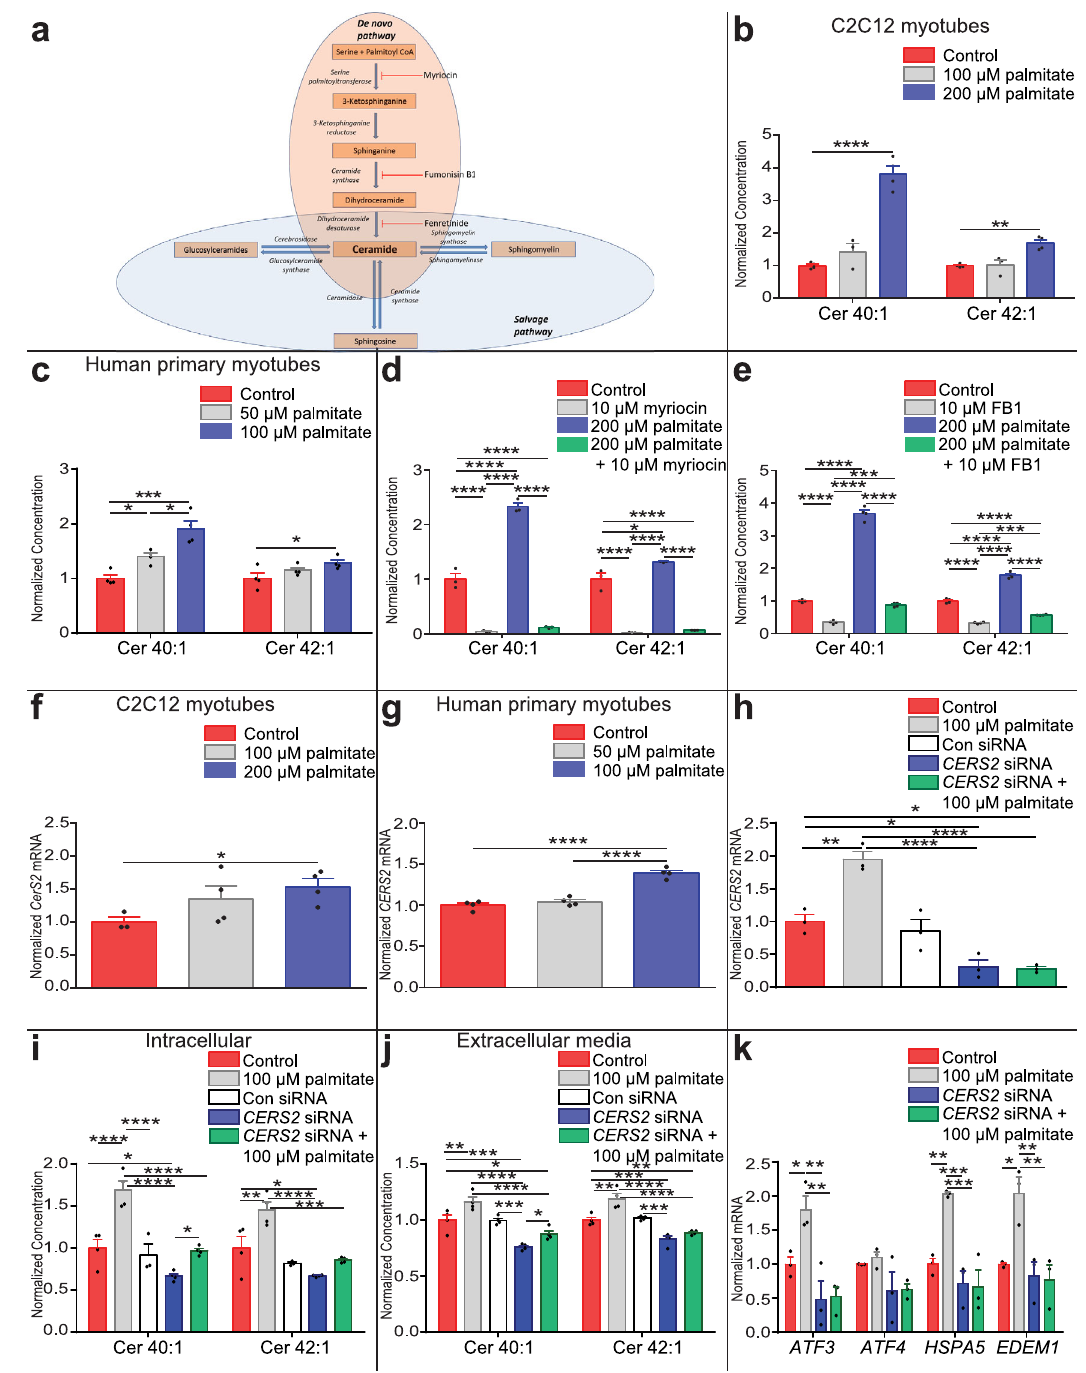
CerS2 H/A) compared to wild type littermate controls. Tissues of the Homo CerS2 H/A mouse exhibit a compensatory increase in ceramide 34:1 concentration (Supplementary Fig. 7a, b) 29 . To limit compensatory effects and generate a more physiological model we also used the Het CerS2 H/A mouse which is not characterised by compensatory increases in shorter chain ceramides (Supplemen- tary Fig. 7a, b). The concentrations of ceramide 40:1 and 42:1 were depleted in plasma and muscle of Het CerS2 H/A, and Homo CerS2 H/A mice in a gene-dosage responsive manner. We then assessed whether heterozygous and homozygous catalytic inacti- vation of CerS2 and subsequent decreases in the long-chain cer- amides altered skeletal muscle expression of UPR genes. The